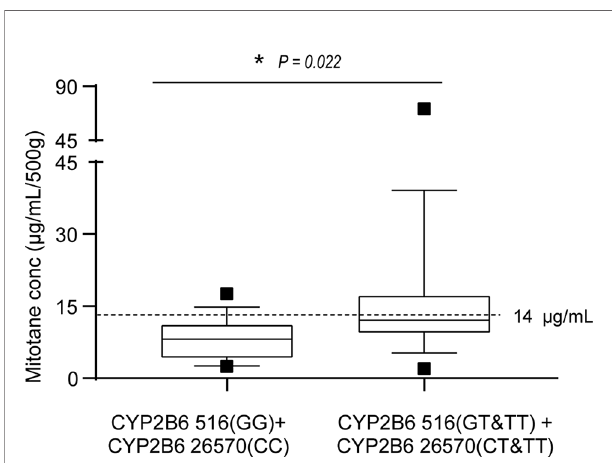
FIGURE 4 | Effects of CYP2B6 516 and CYP2B6 26570 polymorphismson the steady-state mean plasma troughconcentrationsof mitotane. Graphicalanalysis was performed usinga box and whiskersplot. The box spanneddata between two quartiles (IQR),with the median representedas a boldhorizontal line. The ends of the whiskers(vertical lines)represent the smallest and largest values that are not outliers. Outliers(black square) are values between 1.5 and 3 IQRs from the endofthe box. * P <0.05 vs . CYP2B6516